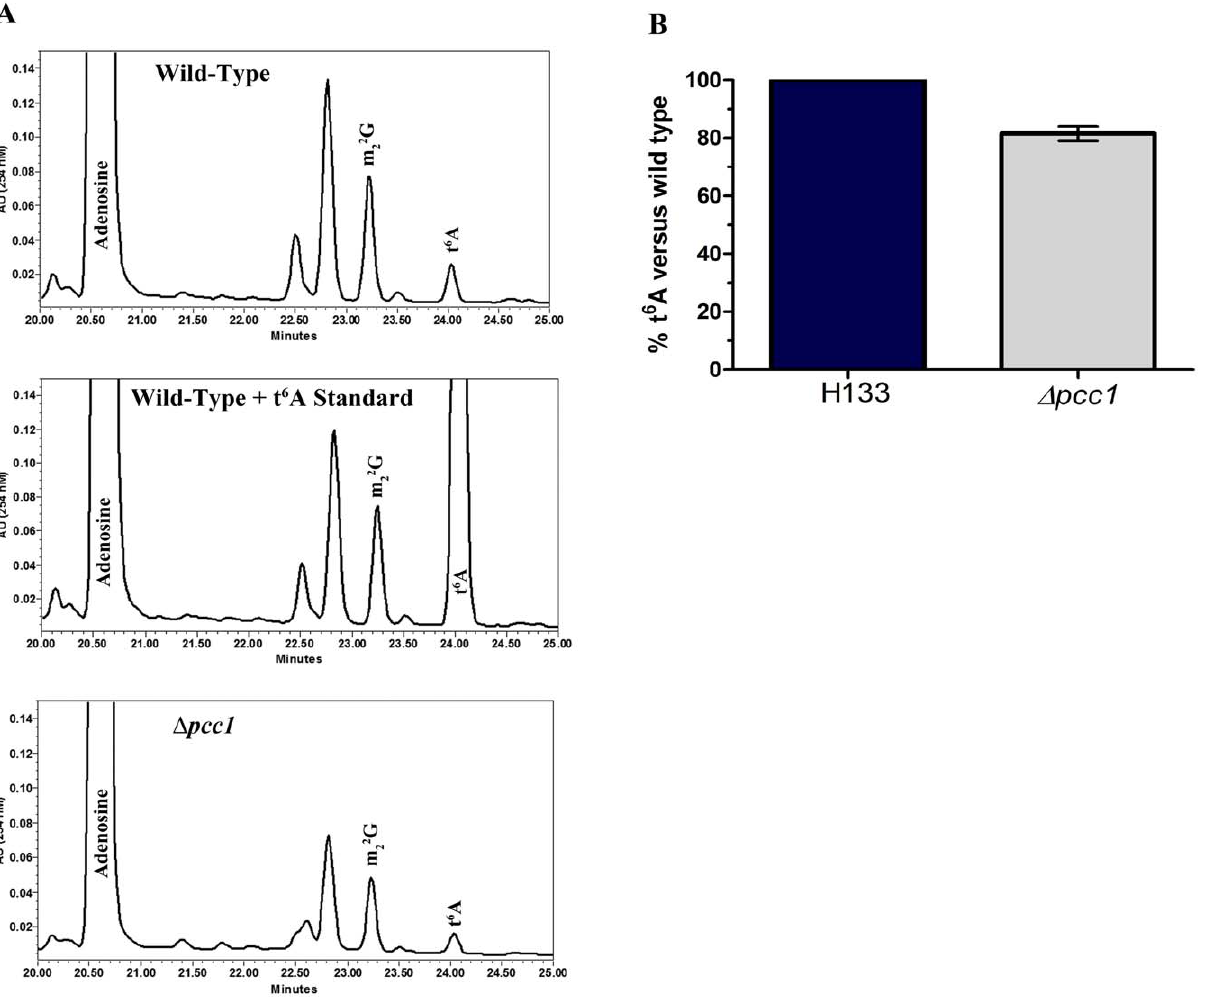
Figure 4. Nucleoside analysis analysis in wild type Haloferaxvolcanii and the D pcc1 mutant cells. tRNAs were extracted from each strain and hydrolyzed to nucleosides. The nucleoside content was determined by HPLC with detection by UV/Vis at 254 nm. Analyses were performed in triplicate from independent cultures. A . HPLC chromatographs of nucleosides from wild-type, wild-type with synthesized t 6 A added, or D pcc1 . t 6 A elutes at 24 minutes. B . Comparison of the t 6 A peak area of wild-type and D pcc1 . The ratios of Y -modified base/m 22 G were used to normalize tRNA concentrations across samples with t 6 A peak area of wild-type set at 100%. D pcc1 contains approximately 19% less t 6 A than wild-type ( P =0.02).